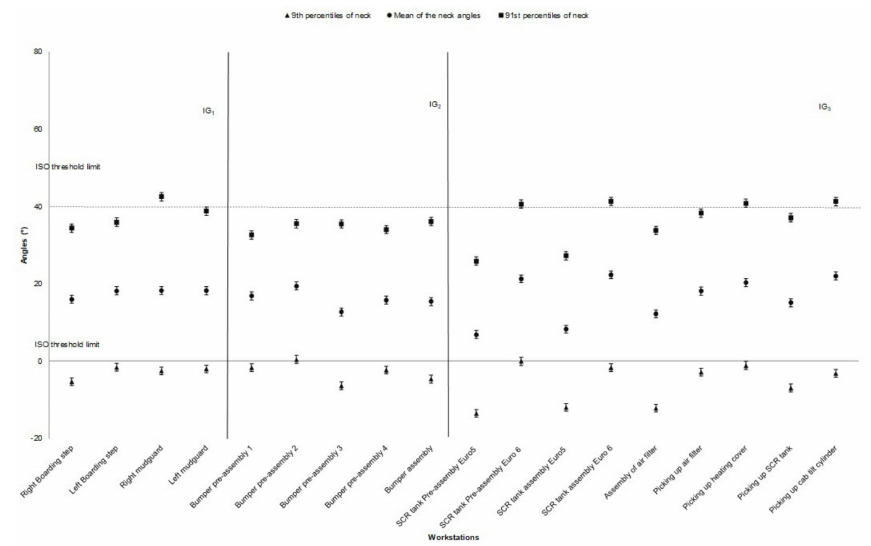
Figure 2. The neck angle (the mean, 91st, and 9th percentiles) for di ff erent workstations in the truck assembly plant, (the bars represent standard deviations). The high-risk ISO threshold limit is 40 ◦ for neck flexion and 0 ◦ for neck extension. Note: IG = Improvement Group; error bars represent standard error.